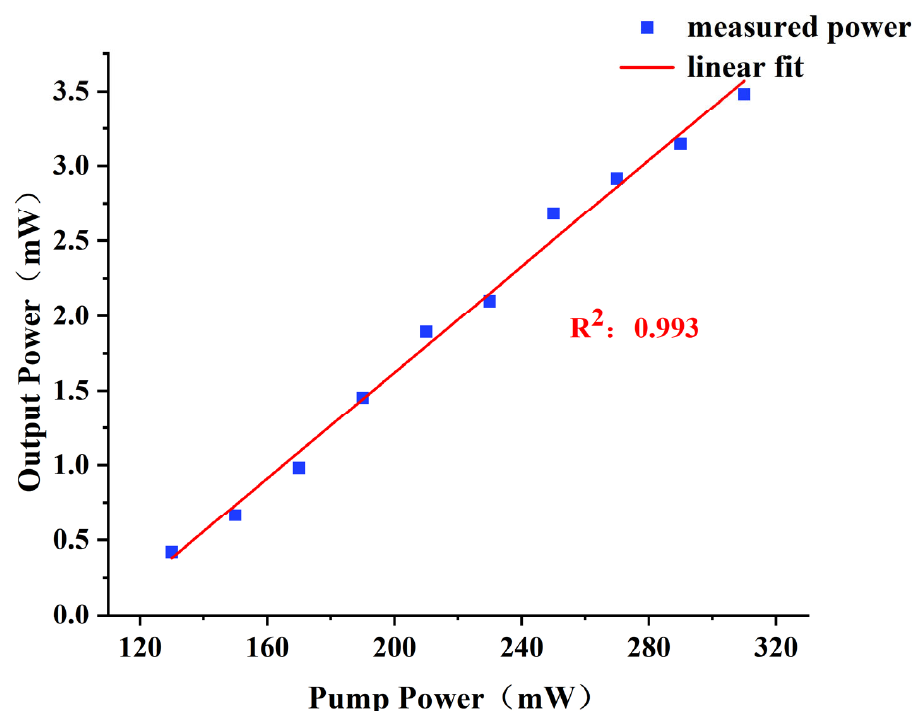
Figure 8. Corresponding relationship between pumping power and the output power of the DW ‐ EDFL.